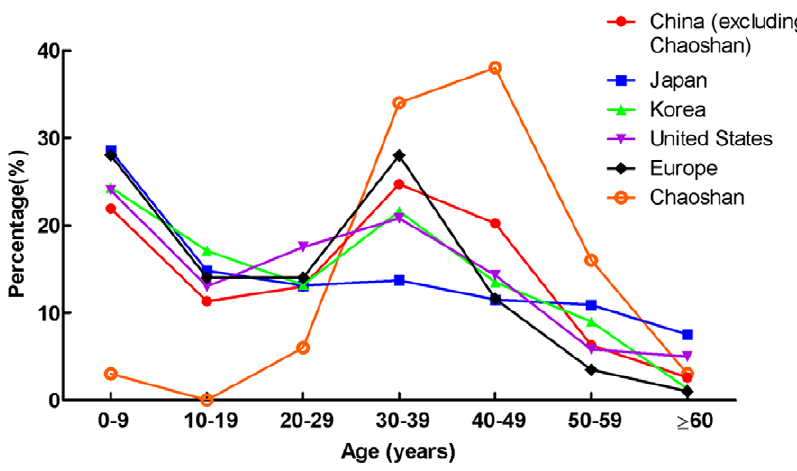
Figure 7. Onset age distribution of MMD in different districts.